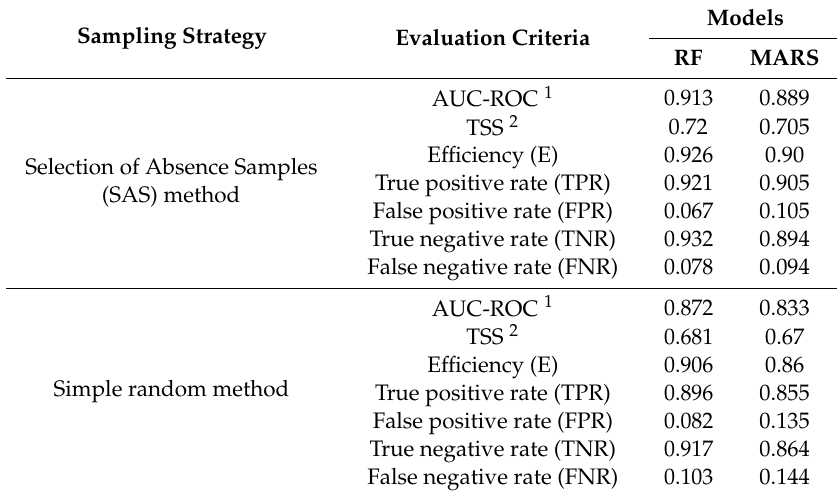
Table 6. Predictive performance of the random forest (RF) and multivariate adaptive regression splines (MARS) models in di ff erent sampling